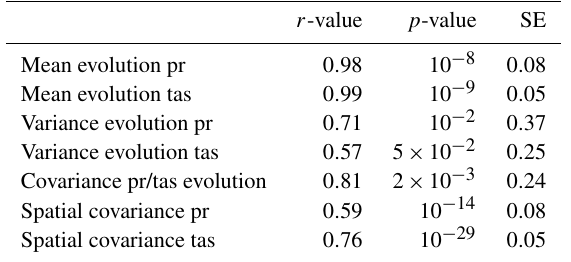
Table 2. r -value, p -value and standard error (SE) of linear regres- sion between the evolution of correction and evolution of WRF. r -value p -value SE Mean evolution pr 0 . 98 10 − 8 0 . 08 Mean evolution tas 0 . 99 10 − 9 0 . 05 Variance evolution pr 0 . 71 10 − 2 0 . 37 Variance evolution tas 0 . 57 0 .